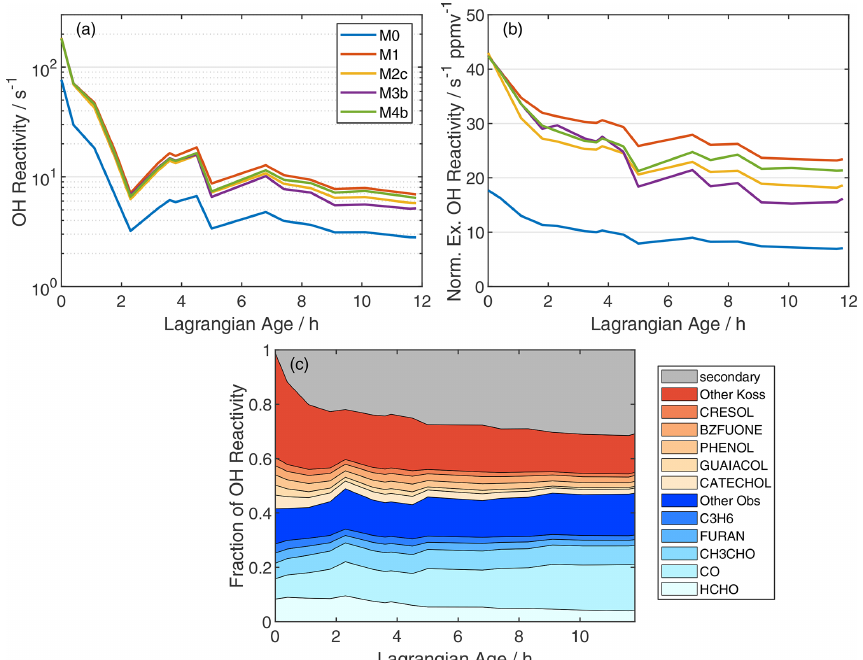
Figure 4. (a) Age evolution of total model OH reactivity, (b) normalized excess OH reactivity, and (c) fractional contributions of individual reactants to total OH reactivity in simulation M1. In panel (b) , normalization is analogous to NEMR calculation (Eq. 1), and the OH reactivity background is 1.1s − 1 , based on summation over observed OH reactants in the background sample. In panel (c) , blue shades denote measured compounds, red shades are species added from the Koss et al. (2018) inventory, and gray includes 2116 other MCM species reacting with